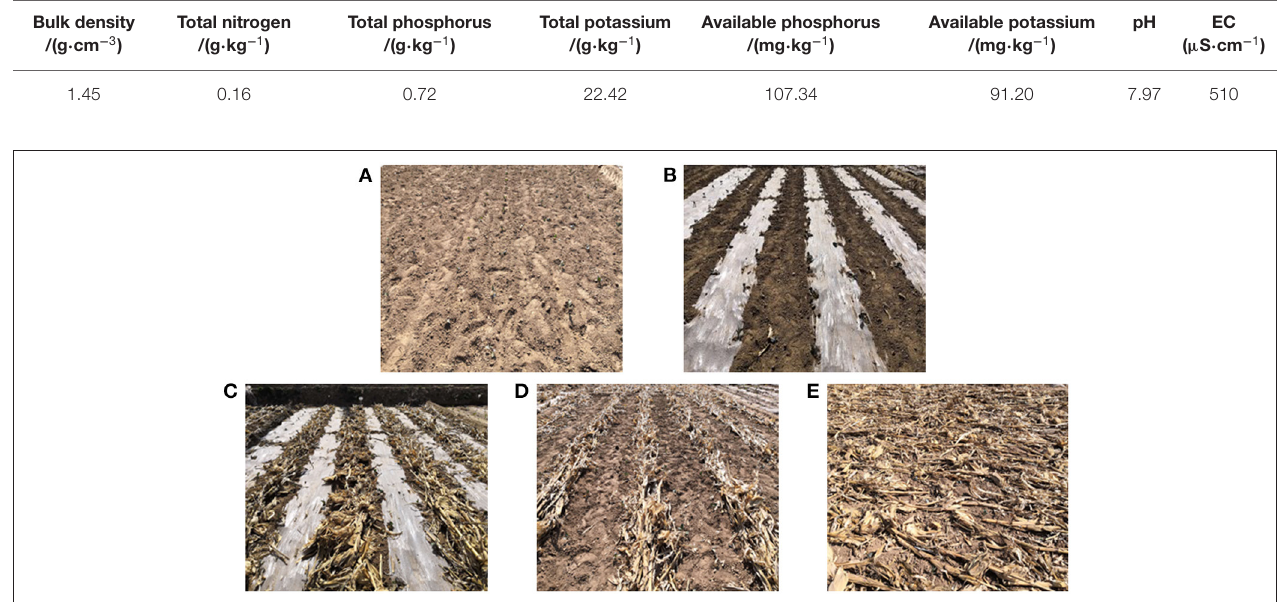
TABLE 1 | Main physical and chemical properties of soil in the arable layer of the experimental site.